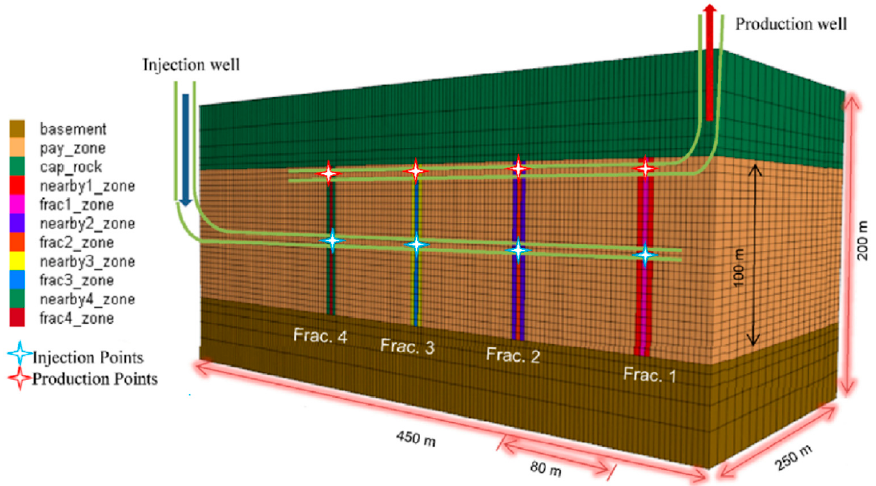
Figure 5. Schematic of equivalent model showing four fracture planes after fracturing in combination of injection and production wells.